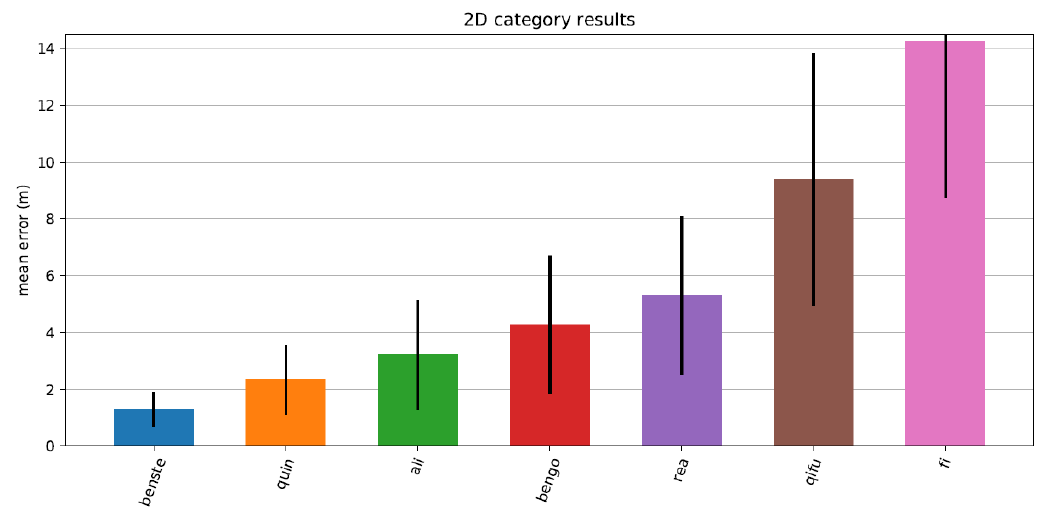
Figure 16. 2 D error in meters as tested in Microsoft Indoor Positioning competition 2018. The STEPS (benste) reached an average accuracy of 1.3 m.